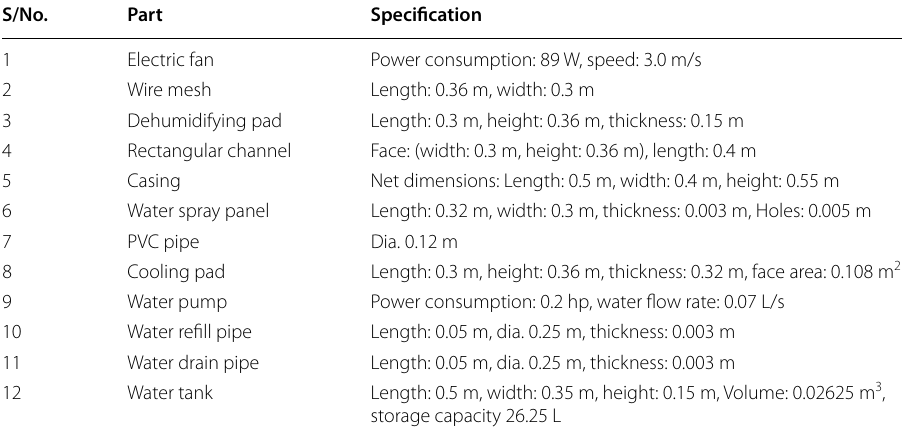
Table 1 System component parts and specifications S/No.